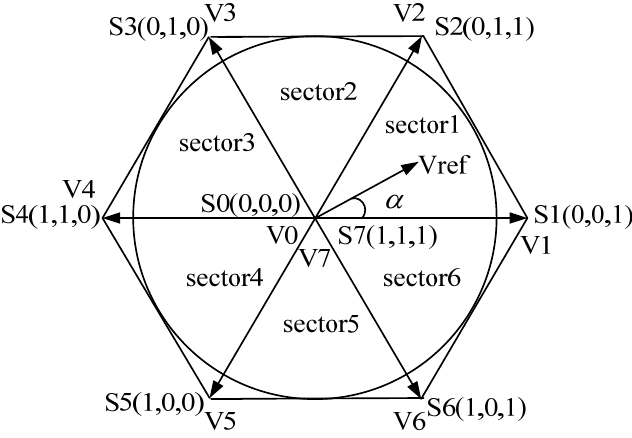
Figure 8. Space vector PWM diagram.